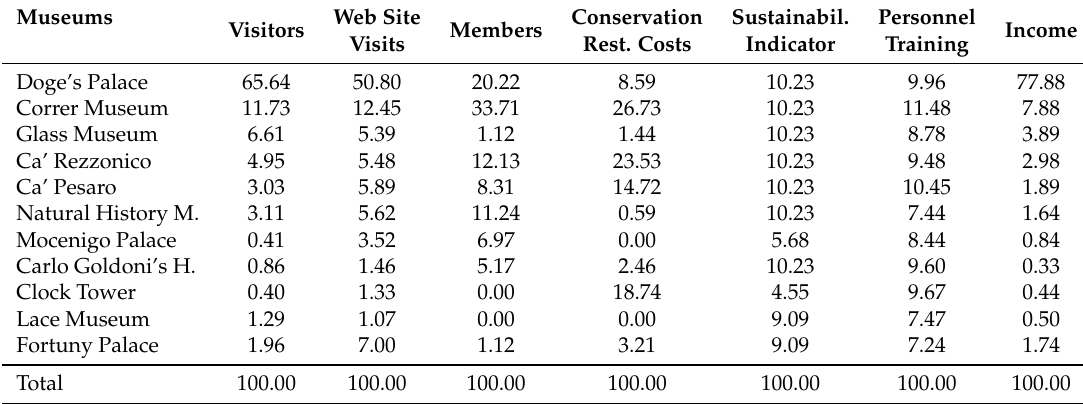
Table 5. MUVE museums: data on output variables (percentage values).